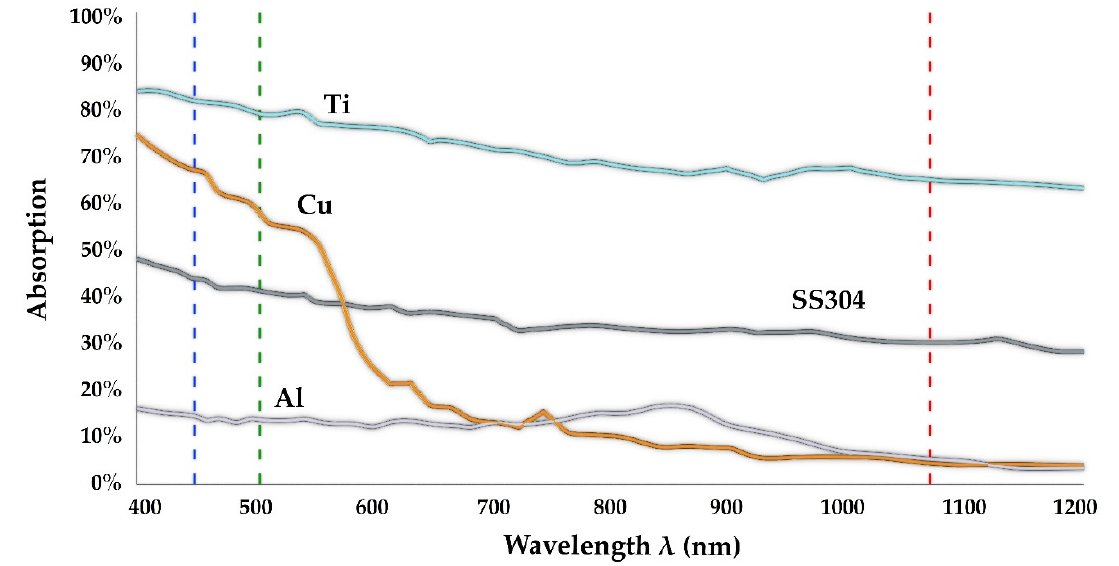
Figure 1. Absorbance vs. wavelength for stainless steel AISI 304, titanium, aluminum, and copper; green, blue, and red laser emission wavelengths are highlighted.